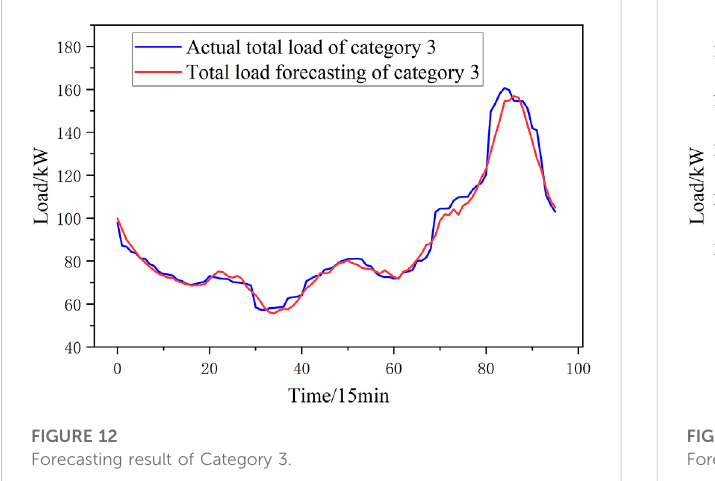
FIGURE 15 Forecasting result of Category 6.